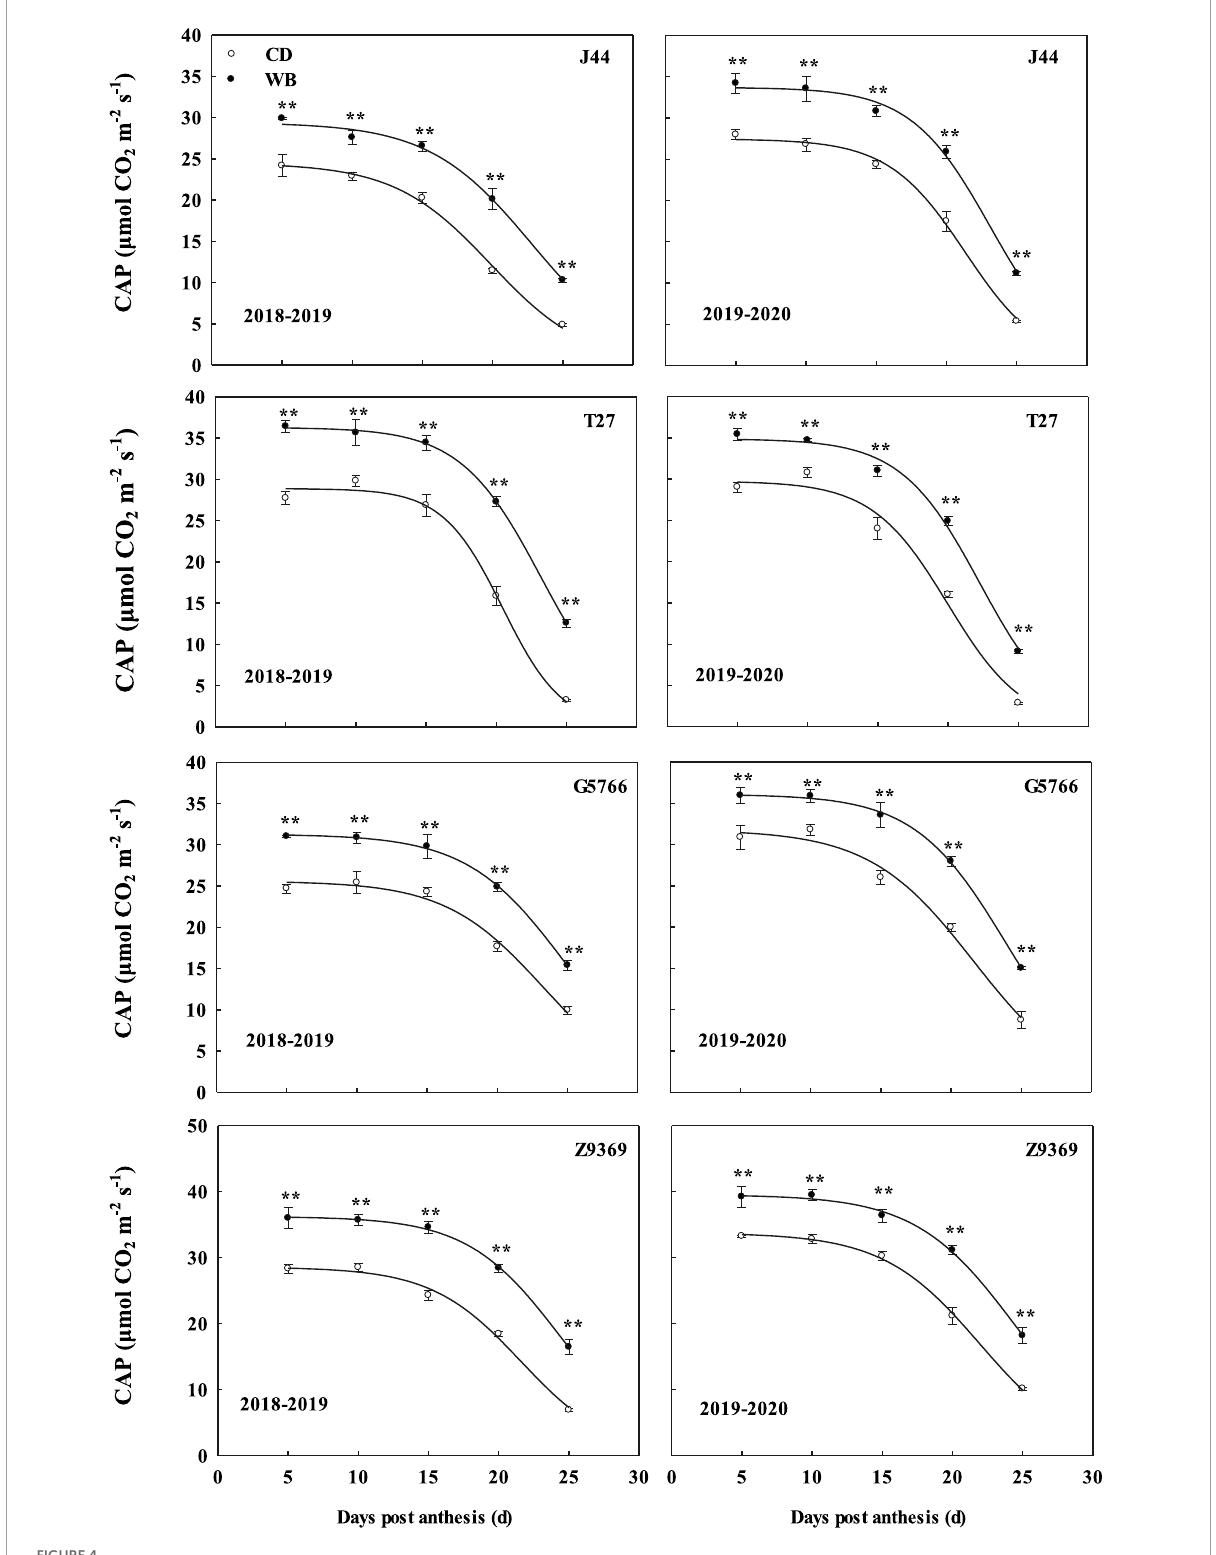
FIGURE4 Effects of sowing pattern on the canopy apparent photosynthesis (CAP) of bread wheat. Values are means of three replicates per treatment. Vertical bars indicate standard error. **Indicates significant differences at P < 0.01 between the two sowing patterns at each measurement time. CD and WB denote the conventional drilling and wide belt sowing pattern,